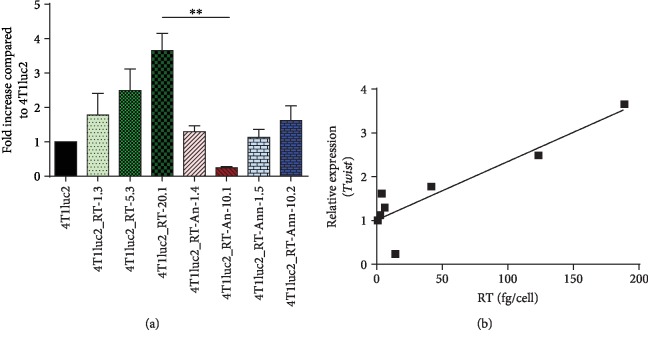
Relative levels of expression of Twist by the derivatives of 4T1luc2 cells expressing variants of consensus HIV-1 FSU_A reverse transcriptase (Table 2) after 14 days in culture (a) and correlation of the relative expression of Twist with the levels of expression of RT_A variants (b). Expression level of Twist was normalized to the expression of HPRT1 and calculated as fold change compared to the levels exhibited by the parental 4T1luc2 cells. Values are presented as mean ± SD from the assay run in triplicates. The amount of RT_A variant produced per cell and expression of Twist at day 14 were correlated using Spearman ranking test (R = 0.9, p = 0.002); ∗∗p < 0.01.